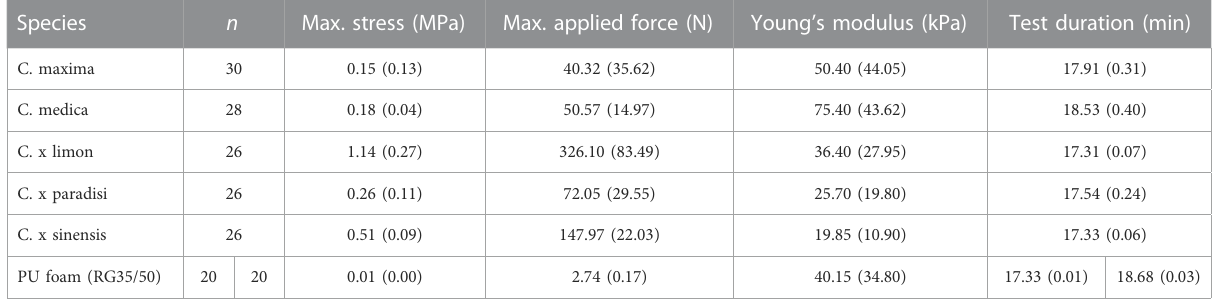
TABLE 4 Median stress of the peel samples and applied force at a strain level of 50% compression; pomelo ( C. maxima ), citron ( C. medica ), lemon ( C . x limon ), grapefruit ( C. x paradisi ), orange ( C. x sinensis ). Median Young ’ s Modulus is calculated up to a strain of 0.5% compression. PU foam (RG35/50) specimens with both sample heights (6.5 mm and 20 mm) were pooled for max. stress, applied force, and Young ’ s Modulus.